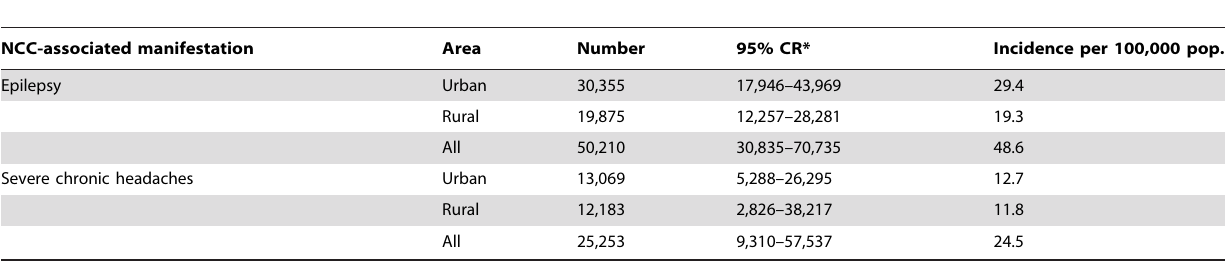
Table 4. Estimated annual incidence cases of NCC-associated epilepsy and severe chronic headaches in Mexico.